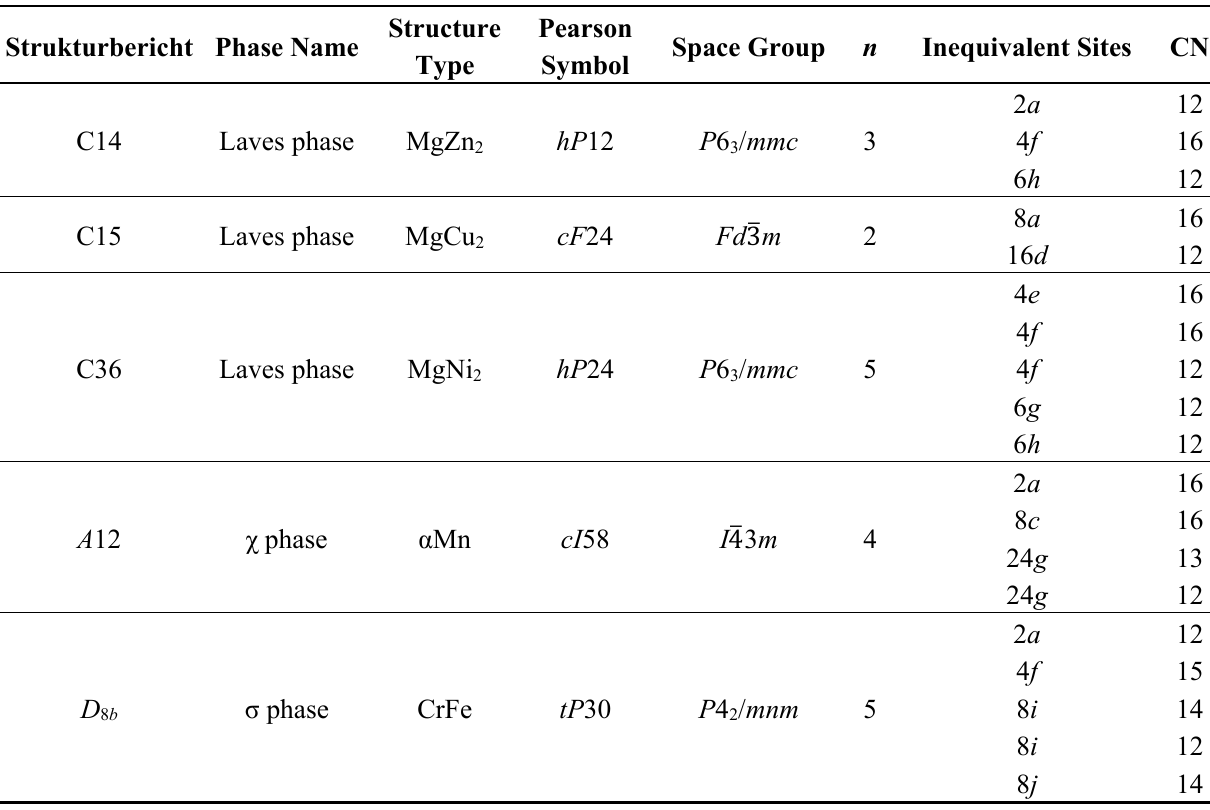
Table 1. List of the phases discussed in the following sections, with major crystallographic information. Strukturbericht Phase